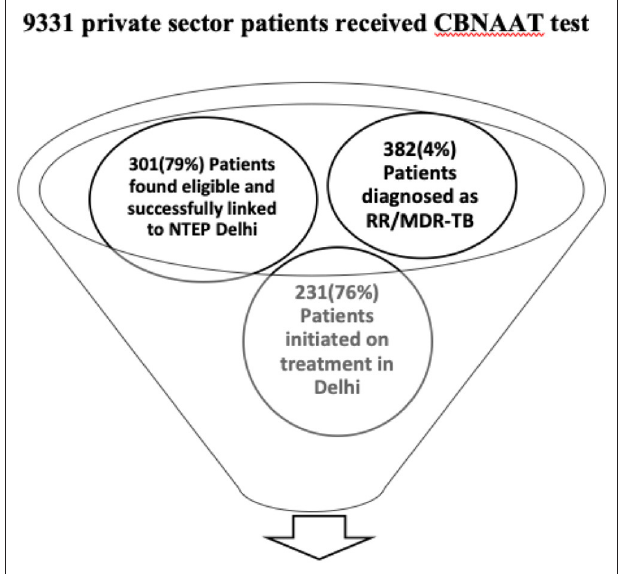
FIGURE 1 | Patient care cascade of private sector patients subjected to CB-NAAT test and initiated on